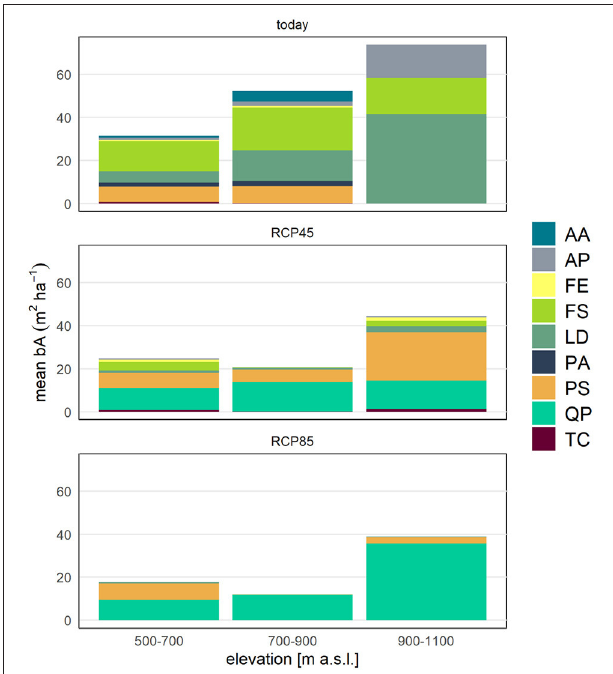
FIGURE 8 | Current (“today”; based on field data) and future (“RCP4.5” and RCP8.5” in 50 years) mean basal area per elevation level and main species. Species abbreviations: AA, Abies alba ; AP, Acer pseudoplatanus ; FE, Fraxinus excelsior ; FS, Fagus sylvatica ; LD, Larix decidua ; PA, Picea abies ; PS, Pinus sylvestris ; QP, Quercus pubescens ; TC, Tilia cordata